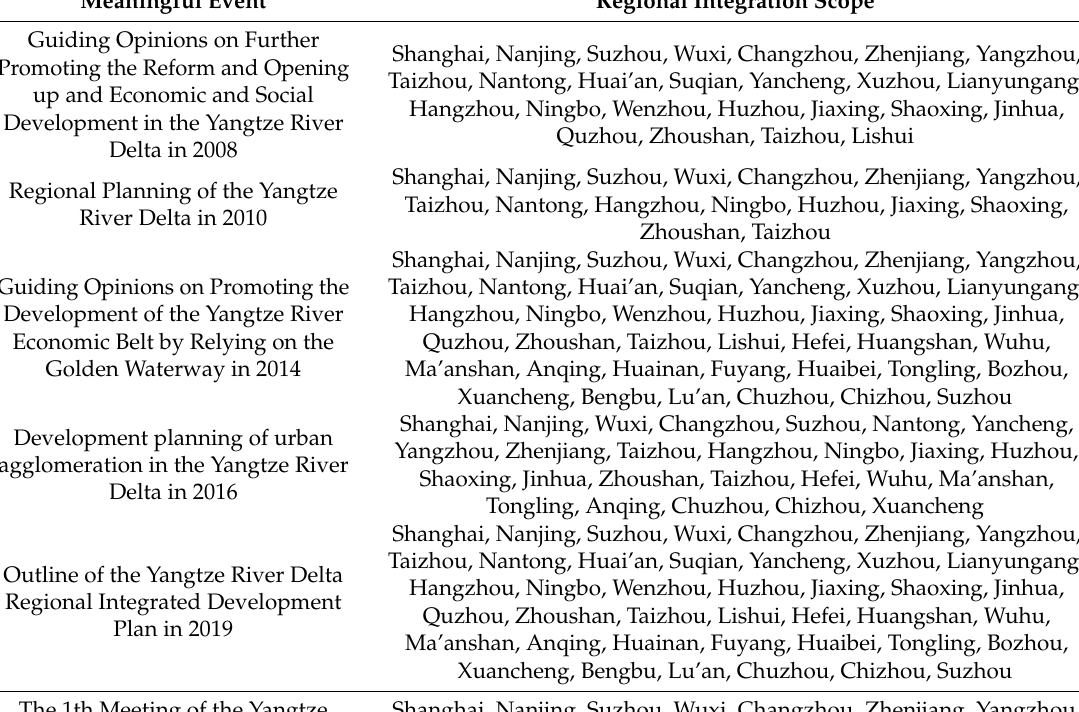
Table 1. The regional integration scope evolution of the Yangtze River